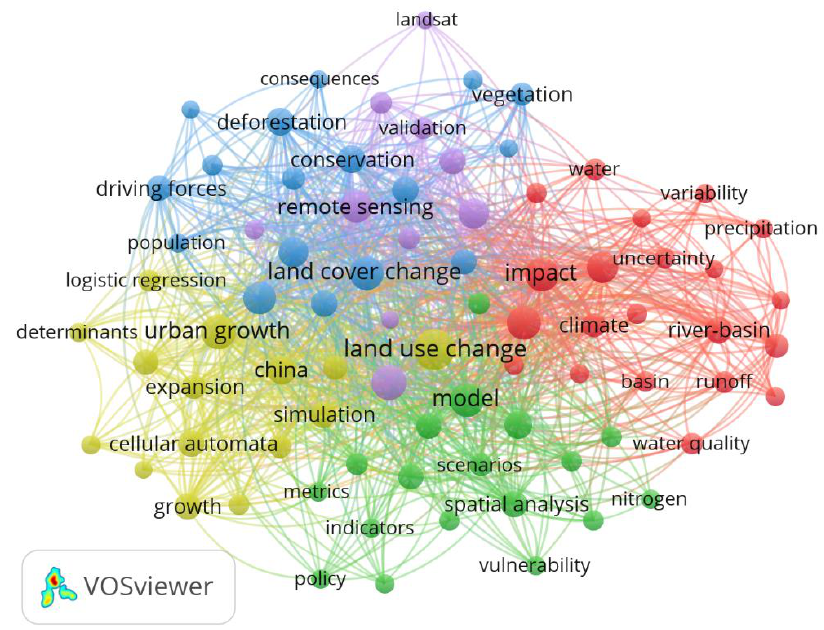
Figure 5. The 25-time keywords occurrence (fractional counting).